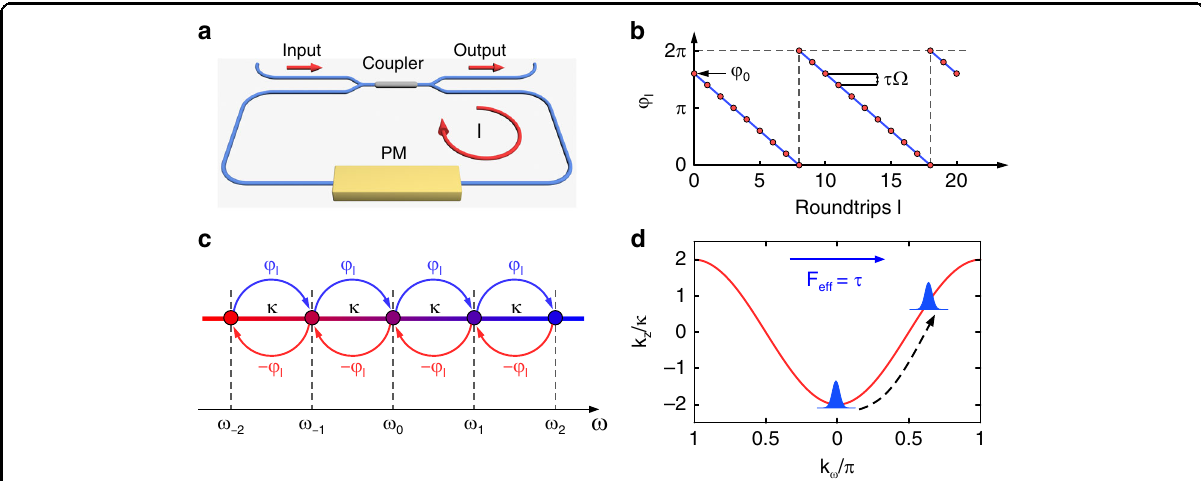
Fig. 1 Conceptual diagram of the arti fi cial frequency lattice and effective force in the phase modulator. a Schematic sketch of the fi bre loop. l denotes the number of roundtrips. The red arrows indicate the propagation direction of the pulse. b Schematic diagram of the phase φ l . The red dots denote the phase of the modulation signal. τ is the time detuning between the optical pulse and modulation signal. Ω and φ 0 are the frequency and initial phase of the modulation signal, respectively. c Mode coupling in the vicinity of ω 0 . κ is the coupling strength between the adjacent modes. φ l and − φ l denote the phase shifts for upward and downward transitions in the frequency. d Dispersion relation of the frequency Bloch mode for φ l = 0. The time detuning τ plays the role of effective electric- fi eld force F